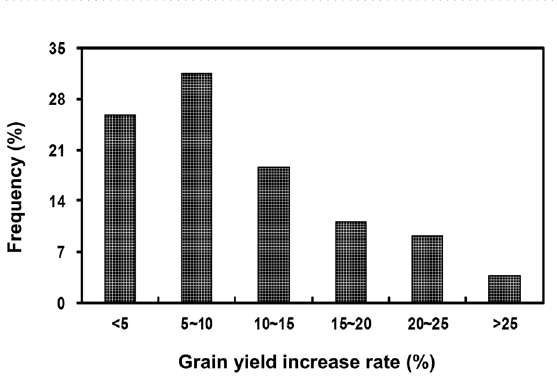
Figure 2. Rice grain yield and K uptake by aboveground for all trails sites.